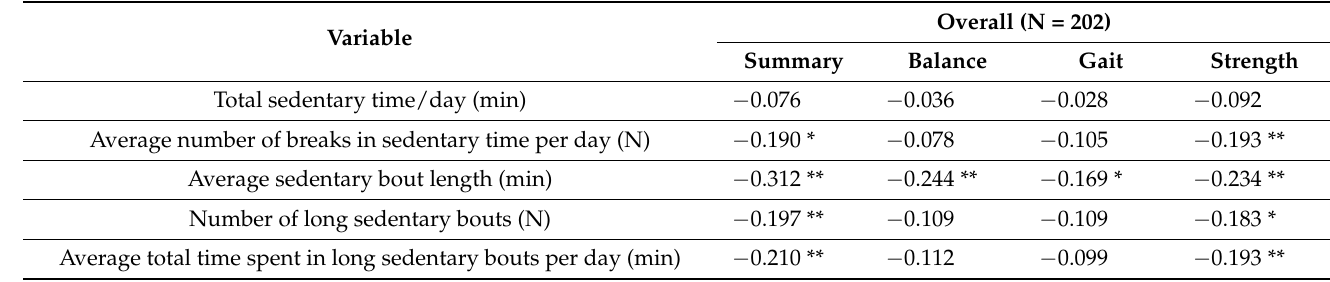
Table 3. Spearman rank-order bivariate correlations between volume and pattern of sedentary behavior and summary and component scores of the Short Physical Performance Battery (SPPB) for the overall sample of persons with multiple